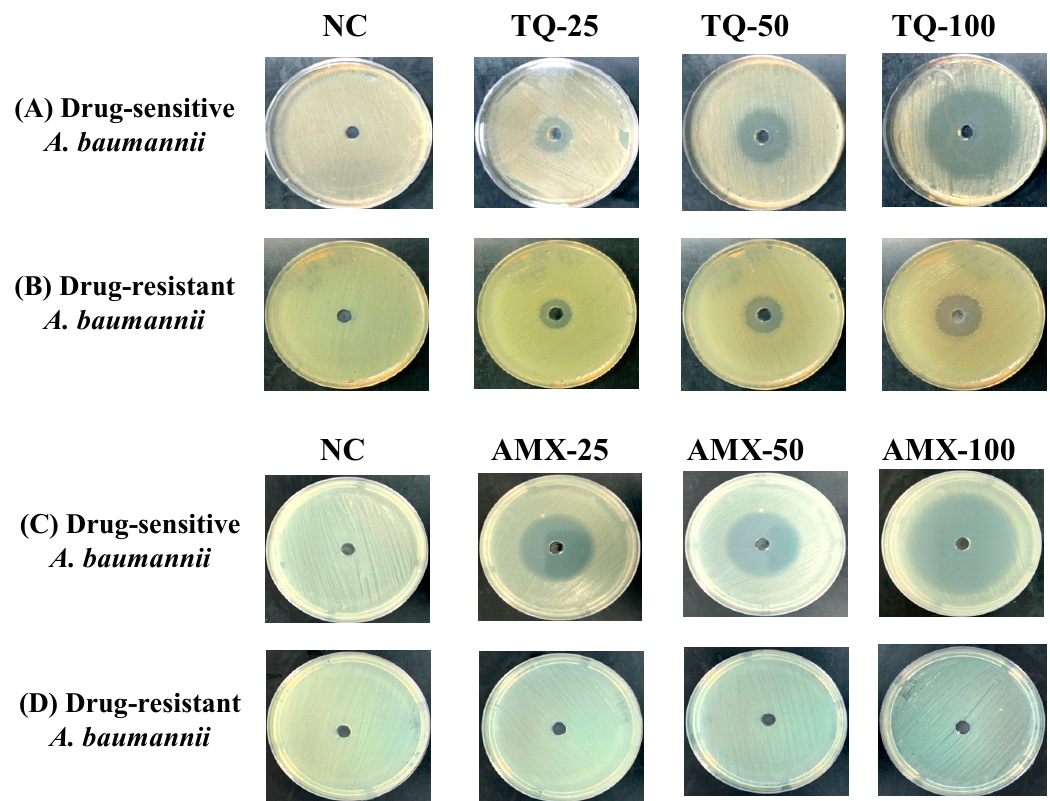
Figure 3. The activity of TQ or AMX against the drug-sensitive and drug-resistant A. baumannii . The activity of TQ (25, 50 and 100 µ g/mL) against the ( A ) drug-sensitive and ( B ) drug-resistant A. baumannii . The activity of AMX (25, 50 and 100 µ g/mL) against the ( C ) drug-sensitive and ( D ) drug-resistant A. baumannii . Negative controls (NC) contain 5% DMSO.